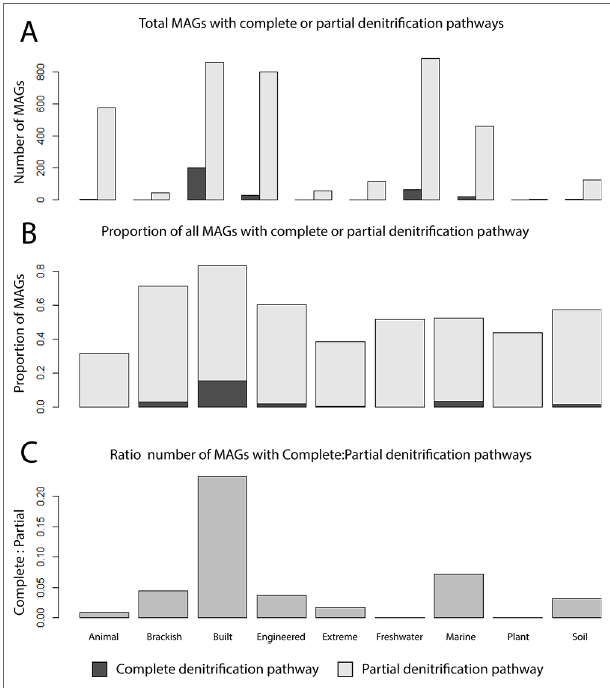
FIGURE 4 | Proportions of complete and partial denitrifiers across different ecosystems. (A) Number of MAGs encoding all proteins to reduce NO 3− to N 2 (complete denitrifiers) compared to the number of MAGs with one or more of the respective genes missing. (B) Proportion of MAGs of the total community that were either partial denitrifiers or complete denitrifiers. (C) Ratio of complete to partial denitrification pathways.